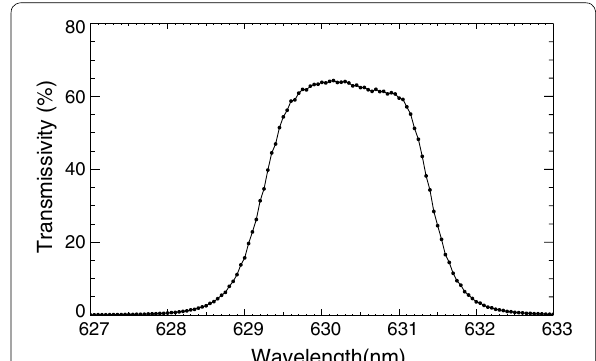
Fig. 22 Transmissivity of the bandpass filter for the 630 nm emission; Transmissivity (in %) of the bandpass filter for the 630 nm emission as function of wavelength (nm) between 627 and 633